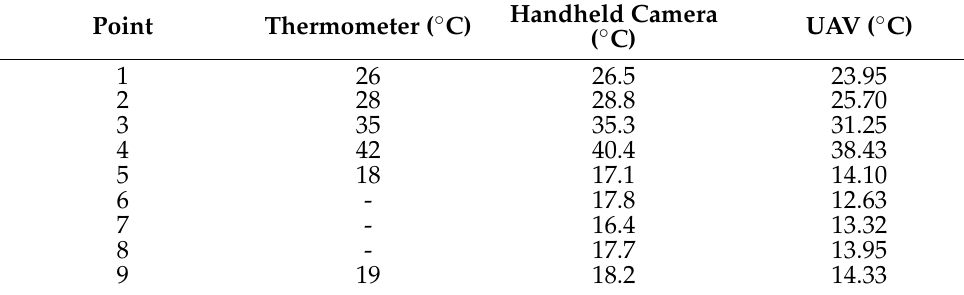
Table 4. Measurements for the thermal